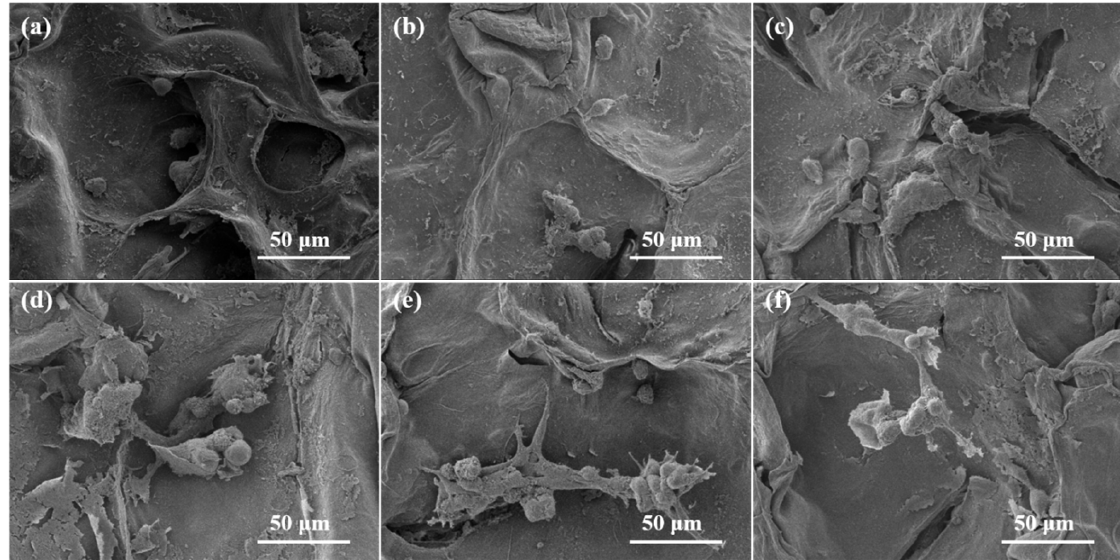
Figure 10. SEM images of osteoblastic MC3T3-E1 cells cultured on the composite scaffolds for 2 days: ( a ) Alg-CS-GT, ( b ) Alg/0.1% BCNs-CS-GT, ( c ) Alg/0.2% BCNs-CS-GT, ( d ) Alg/0.3% BCNs-CS-GT, ( e ) Alg/0.4% BCNs-CS-GT and ( f ) Alg/0.5% BCNs-CS-GT.